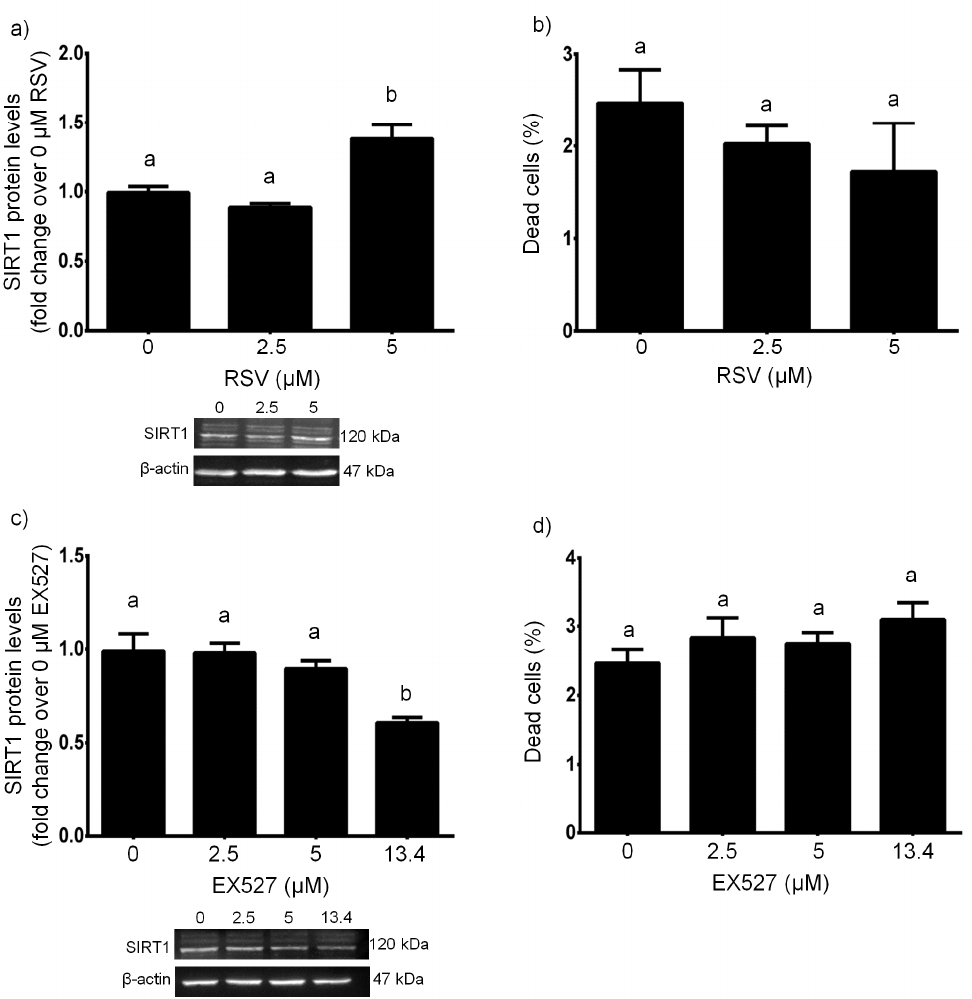
Figure 1. Effects of a 24-h treatment with either resveratrol ( a , b ) or EX527 ( c , d ) on sirtuin 1 protein levels ( a,c ) and cell death ( b,d ) in HUVECs. Representative blots are also shown (panels a and c).